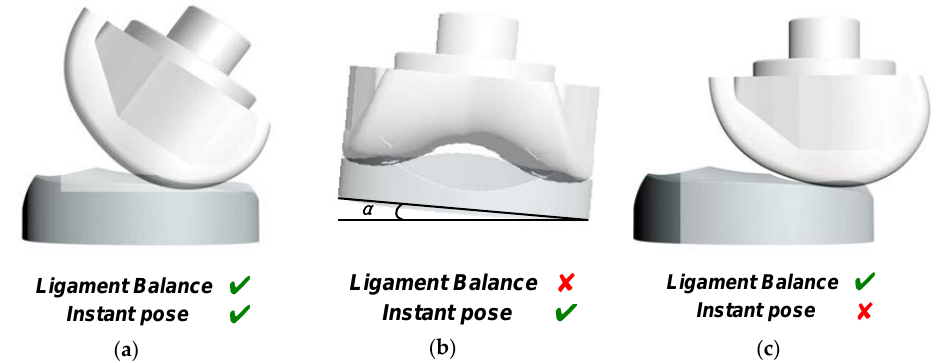
Figure 3. Typical situations of the knee joint prosthesis of total knee arthroplasty (TKA) surgery: ( a ) the joint prosthesis is well installed, ( b ) inappropriate condition with the spacer tilted, ( c ) inappropriate condition with malalignment between the spacer and the femoral component.